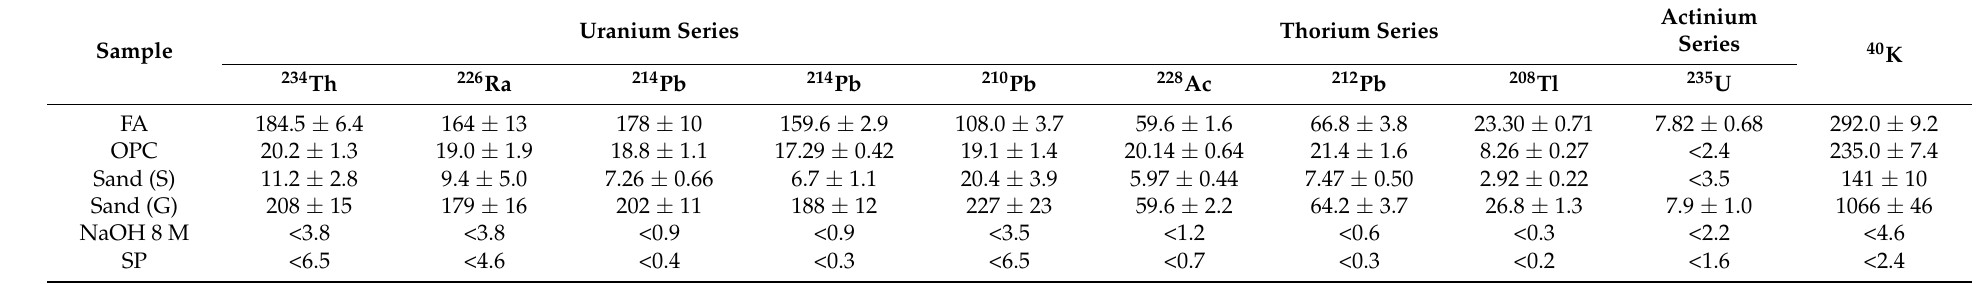
Table 9. Activity concentrations for radionuclides in the uranium, thorium, and actinium radioactive series and 40 K for the seven elements analysed in this study.